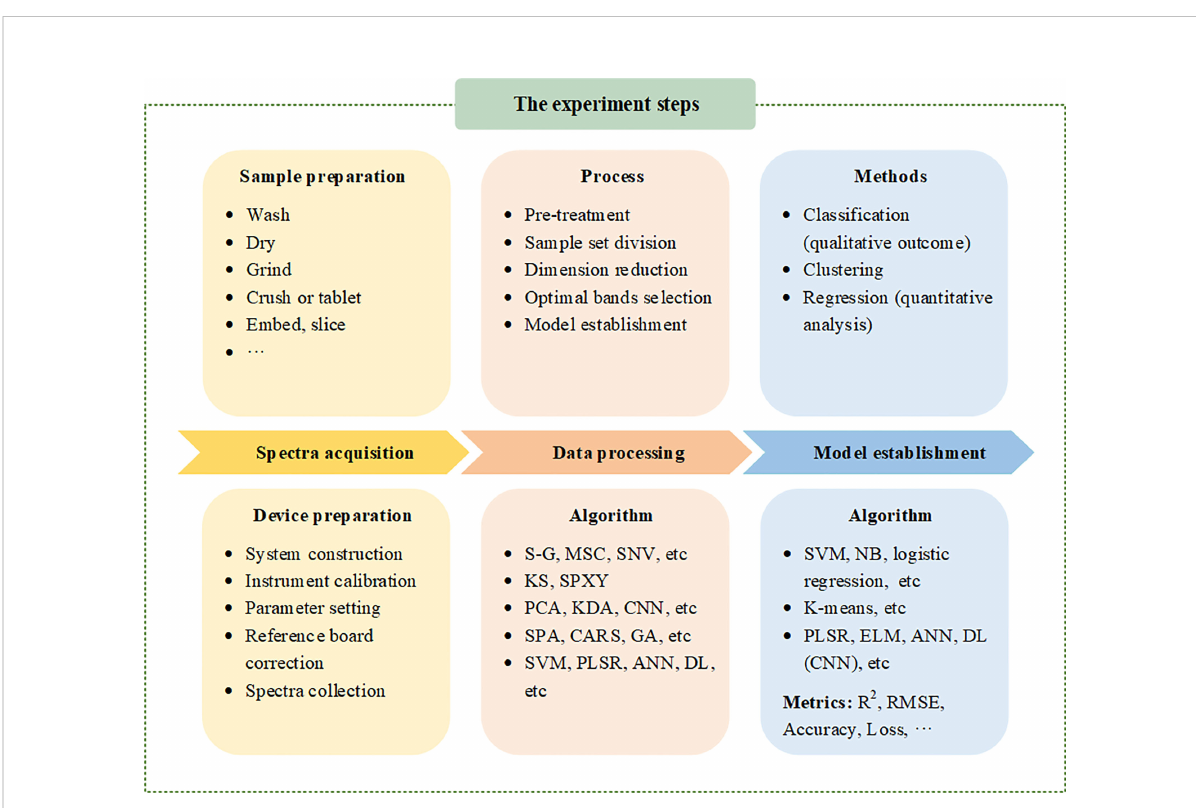
FIGURE 3 The major steps of the experiment are sample preparation, spectra acquisition and computational